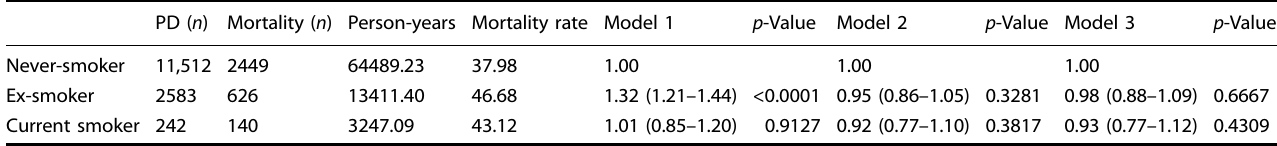
Table 3. Cox proportional hazard regression analysis on the risk of all-cause mortality in individuals with Parkinson ’ s disease with two health screening data according to smoking.